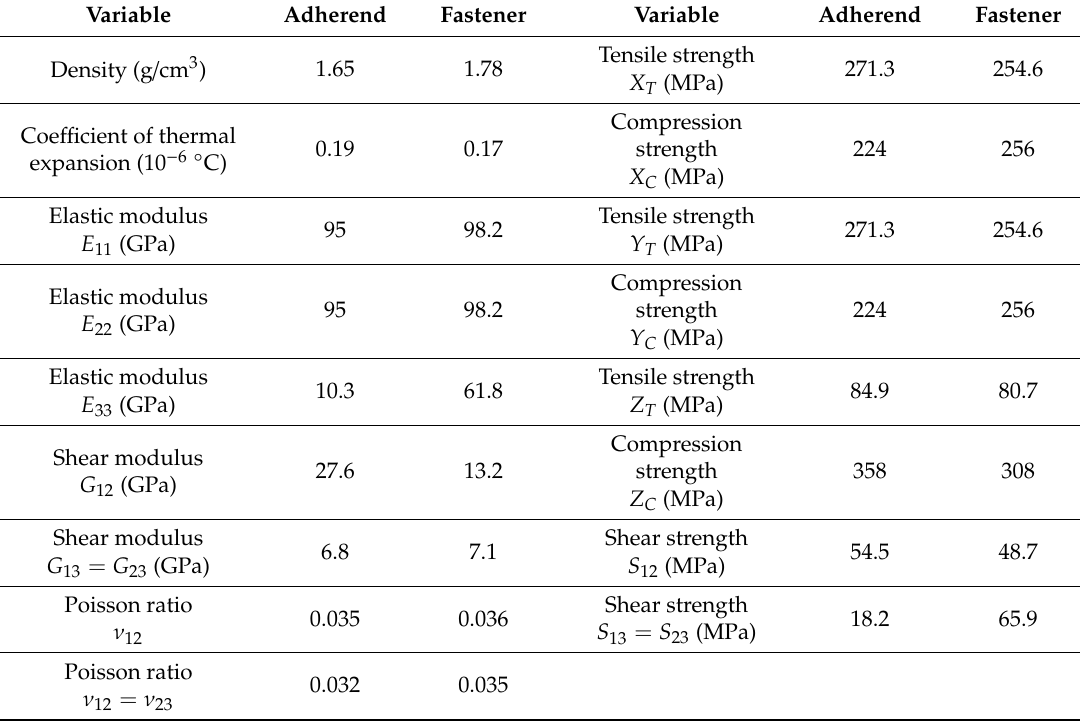
Table 2. Process parameters of chemical vapor infiltration (CVI) and chemical vapor deposition (CVD).